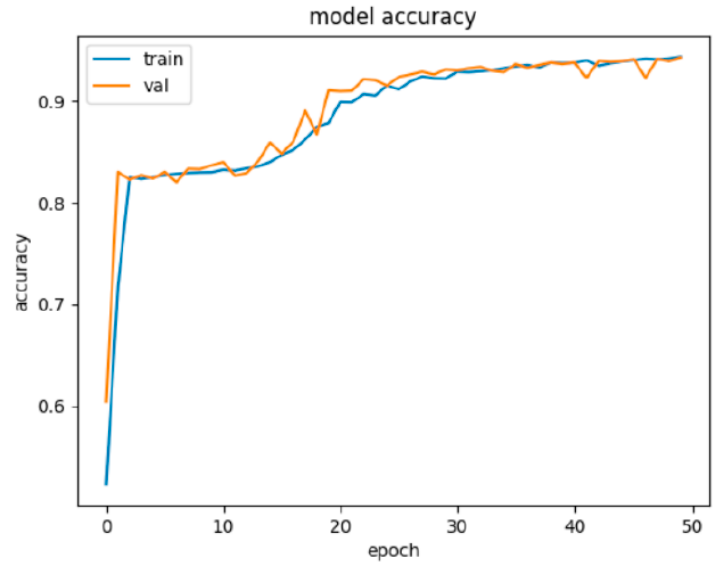
Figure 4. Graphic visualization of the progress of NN2 learning on the training and validation set.